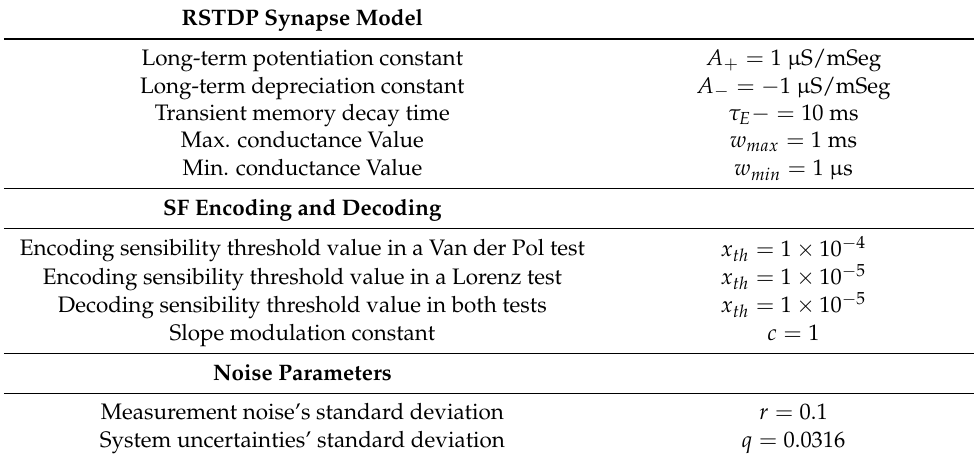
Table 2. Encoding/decoding and RSTDP parameters in the